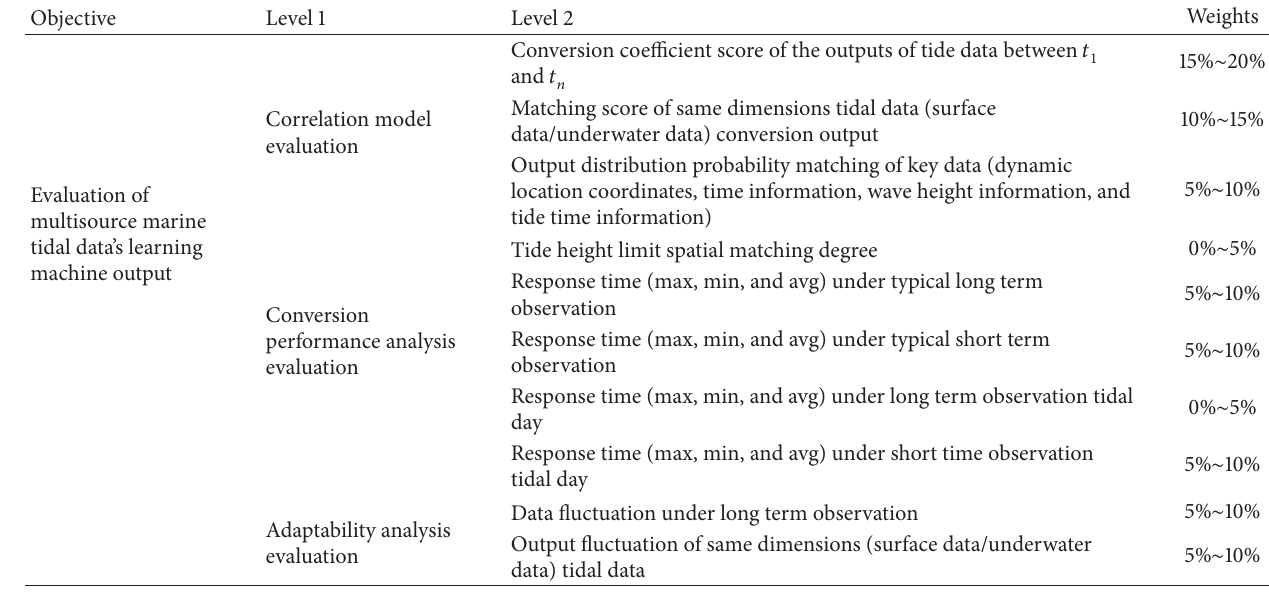
Table 3: Tidal data evaluation factors hierarchy partition.